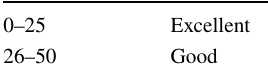
Table 3 Classification of water quality and status based on weighted arithmetic WQI Method